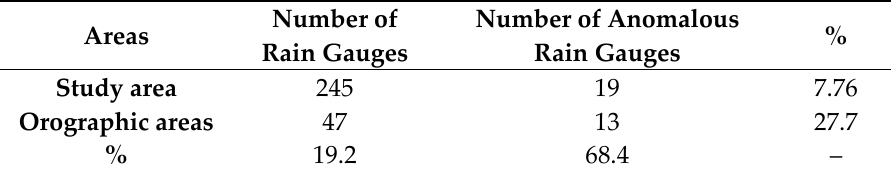
Table 3. Main statistics referred to the location of the “anomalous” rain gauges.